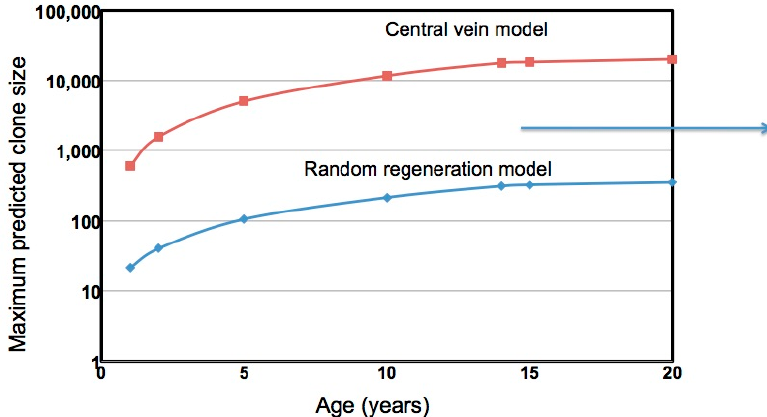
Figure 3. Predictions of hepatocyte clone size based on liver growth and hepatocyte turnover. Two models are compared, one assuming that all hepatocytes contribute to liver growth and hepatocyte turnover (consensus model) [80], the other assuming that proliferation is an exclusive property of hepatocytes surrounding the central vein [70]. In these simulations, hepatocyte clones develop beginning from birth. The liver linearly expands 10-fold in size over a period of 14 years. In both simulations, 0.15% of hepatocytes were replaced daily due to random cell death. Hepatocytes are uniquely marked at time zero to follow their loss and/or clonal expansion. Two FORTRAN computer models of the liver were compared; in the first (csize8), all hepatocytes participate in growth and replacement. In the second (ran-rep-c5), only central vein hepatocytes, considered to represent 1% of total hepatocytes, are able to divide. (Interestingly, if liver growth is not included, then the stem cell model, with 0.15% daily turnover, predicts 42% replacement of the liver with stem cell (central vein hepatocyte) daughters after a year, similar to experimental observations [70]). These FORTRAN models are available upon request from W.S.M. (ws_mason@fccc.edu) or S.L. (S_Litwin@fccc.edu). The right pointing arrow illustrates the average maximum clone size for IT patients ranging from 15 to 39 years of age; no age dependence was observed [63].